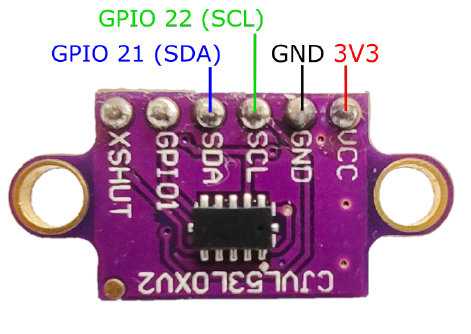
Figure 6. Distance sensor wiring diagram.